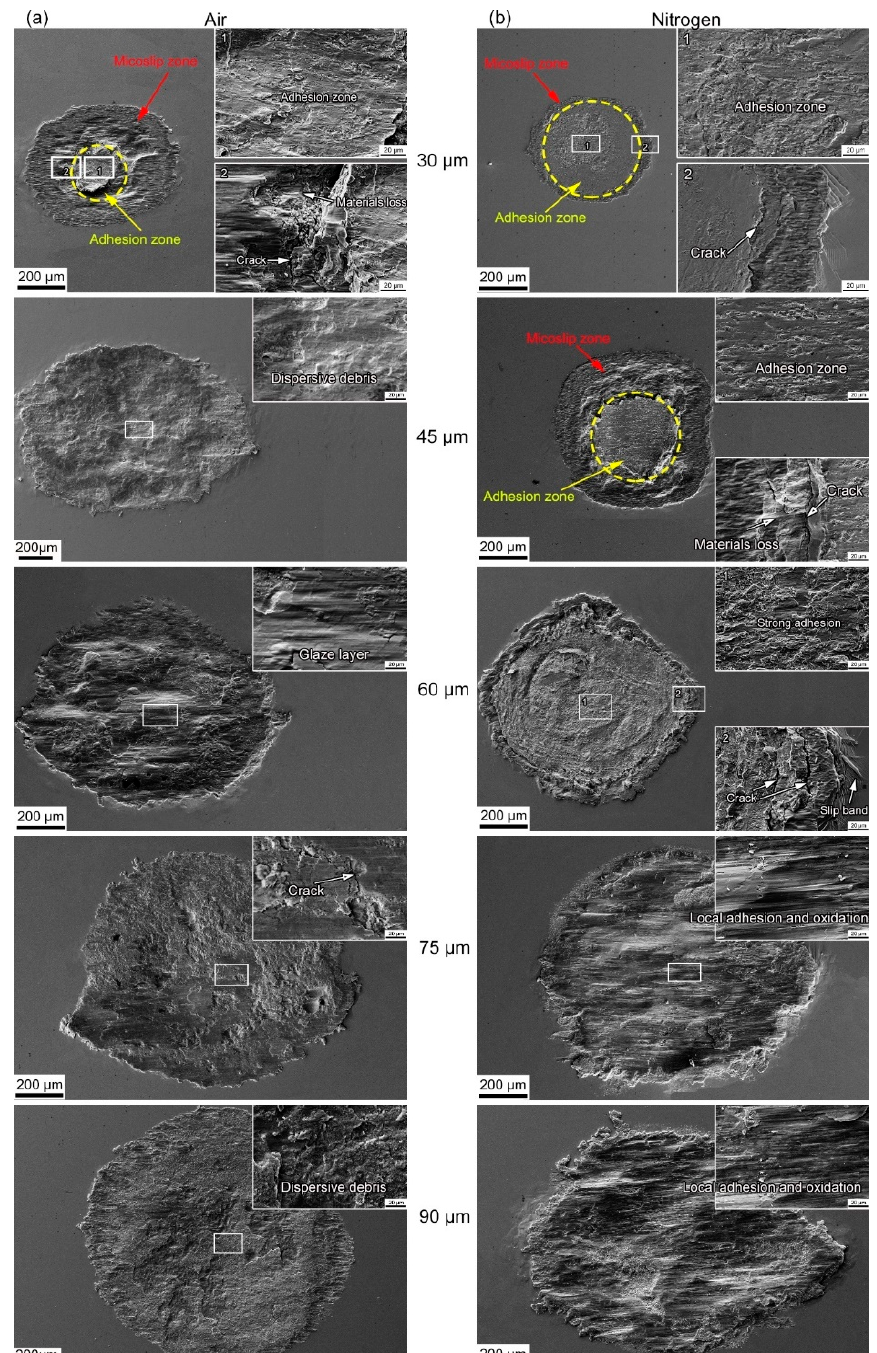
Figure 6. The SEM images of wear surfaces in alloy 690 during fretting wear at different displacement amplitudes in ( a ) air and ( b ) nitrogen.